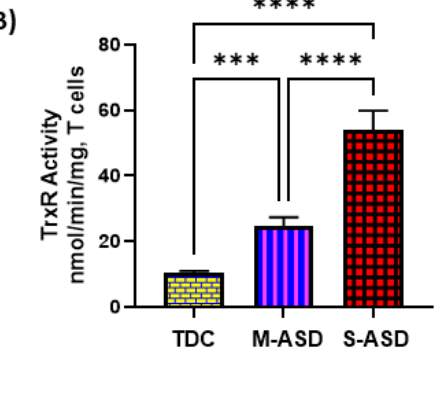
Figure 1. TrxR expression/activity in the T cells of the ASD and TDC groups. ( A ), TrxR1+CD3+T cells, ( B ) TrxR activity in T cells, ( C ) Flow plot displaying the double-positive immunostaining of TrxR1+CD3+T cells. PBMCs and T cells were segregated from whole blood, followed by flow cy- tometry and enzymatic assay, respectively. The ASD group was further divided into mild – moderate (M-ASD) and severe (S-ASD). Values are shown as the mean ± SEM, n = 22 – 25/group. ** p < 0.01; *** p < 0.001, **** p < 0.0001. 3.2. Trx1 Expression Is Downregulated in the T Cells of ASD Subjects Our results show that Trx1 protein expression is decreased in M-ASD CD3+T cells compared to TDC CD3+T cells, however this was not significant (Figure 2A,B). Further, when categorized according to severity, CD3+T cells from the S-ASD group had a further decrease in Trx1 expression compared to the M-ASD group and TDC group (Figure 2A,B). This was evident from the decreased double-positive immunostaining of Trx1+CD3+T cells. These results display that Trx1 expression is decreased in the T cells of ASD children, which may be due to increased oxidative stress.